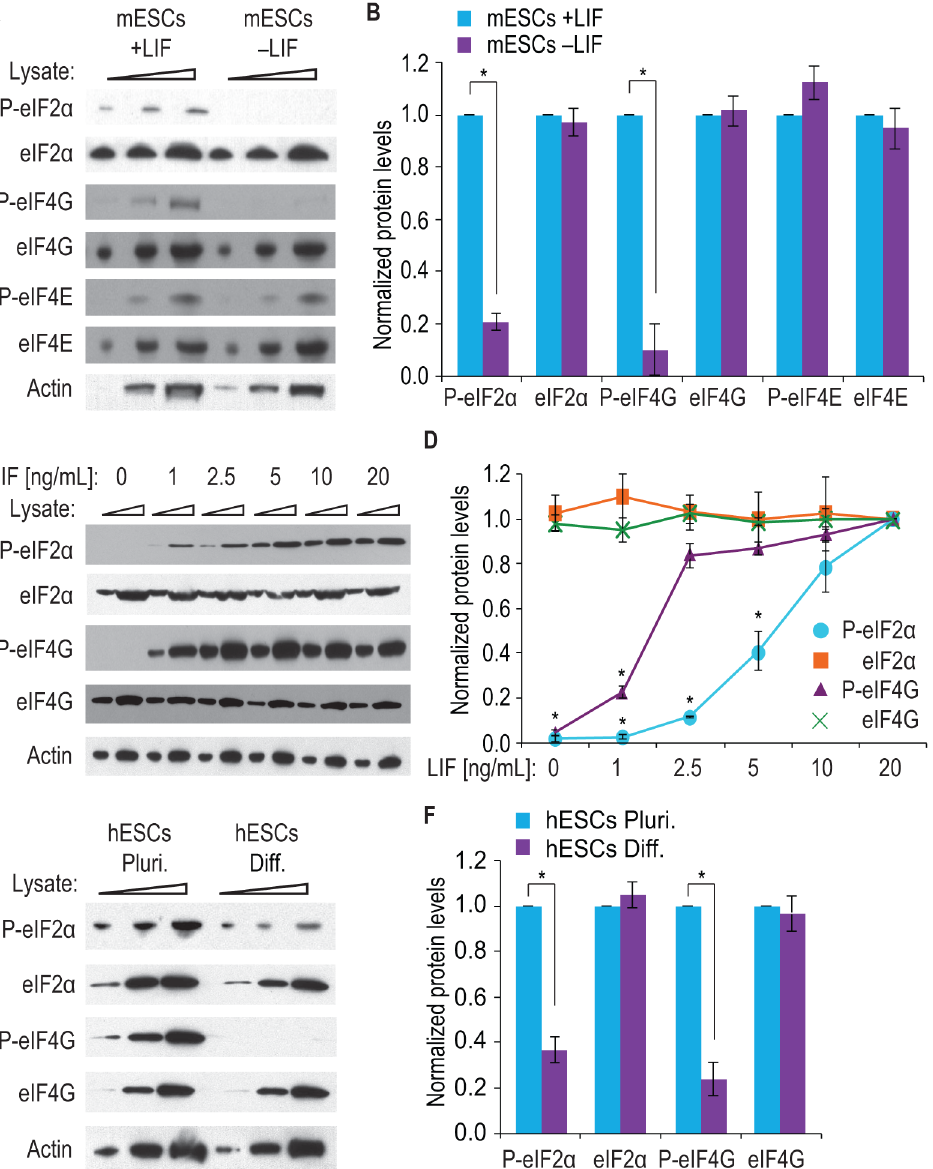
Fig 1. Phosphorylated eIF2 α and eIF4G in mESCs and hESCs. (A) mESCs were cultured either with LIF (mESCs +LIF) or without LIF for 24 h (mESCs – LIF). Increasing amounts of cell lysate (indicated by triangles) were separated by 4 – 12% gradient SDS-PAGE and indicated proteins visualized by western blot. P-eIF2 α , P-eIF4G and P-eIF4E, phosphorylated eukaryotic translation initiation factors; eIF2 α , eIF4G and eIF4E, total eukaryotic translation initiation factors. Actin was probed as a loading control. (B) Three biological replicates, prepared as in (A), were quantitated. Data were normalized to values from mESCs cultured with LIF (mESCs +LIF). Both P-eIF2 α and P-eIF4G are downregulated in mESCs cultured without LIF, whereas P-eIF4E is unchanged. Error bars represent s.d. ( * , p < 0.01 compared to mESCs +LIF samples). (C) mESCs were cultured for 24 h with various concentrations of LIF (10 ng/mL is standard); increasing amounts of cell lysate (indicated by triangles) were separated by SDS-PAGE and analyzed by western blot for indicated proteins. (D) Three biological replicates, prepared as in (C), were quantitated. Data were normalized to values from mESCs cultured with 20 ng/mL LIF. Increasing LIF promotes increasing phosphorylation of eIF2 α and eIF4G. Note that LIF titration promotes eIF4G phosphorylation prior to eIF2 α phosphorylation. Error bars represent s.d. ( * , p < 0.01 compared to 10 ng/mL LIF samples). (E) hESCs were cultured for 24 h with FGF2 and TGF- β (hESCs Pluri.) or under conditions that induce mesendoderm differentiation (hESCs Diff.). Increasing amounts of cellular lysate (indicated by triangles) were separated by SDS-PAGE and western blotted for indicated proteins. (F) Three biological replicates, prepared as in (E), were quantitated. Data were normalized to values from hESCs cultured with FGF2 and TGF- β (hESCs Pluri.). eIF2 α and eIF4G are phosphorylated in pluripotent hESCs more than in early differentiating hESCs (hESCs Diff.). Error bars represent s.d. ( * , p < 0.01 compared to hESCs Pluri.